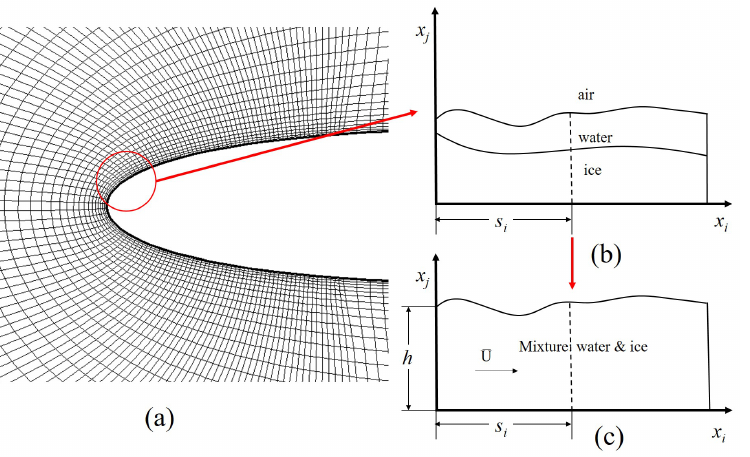
Figure 1. Diagram of ice model simplification: ( a ) the grid required for the calculation of airflow field and droplet trajectory; ( b ) the control volume of ice layer and water film; ( c ) the control volume of